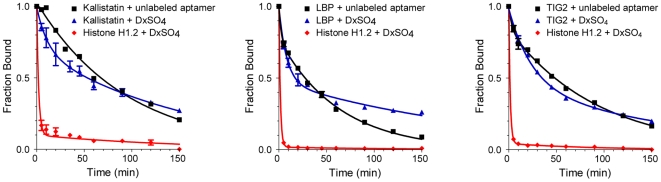
Kinetic discrimination between cognate and non-cognate interactions.Dissociation rate measurements for specific and non-specific protein interactions with representative Kallistatin, LBP, and TIG2 SOMAmers. Histone H1.2 binds to random DNA sequences and was used to demonstrate non-specific binding. The fraction of radiolabeled SOMAmer (10 pM) bound to its cognate target is shown after addition of 50 nM unlabeled SOMAmer (squares) or 0.3 mM dextran sulfate (triangles) as a function of time. Rapid dissociation of non-specific complexes in the presence of 0.3 mM dextran sulfate is also shown (diamonds).